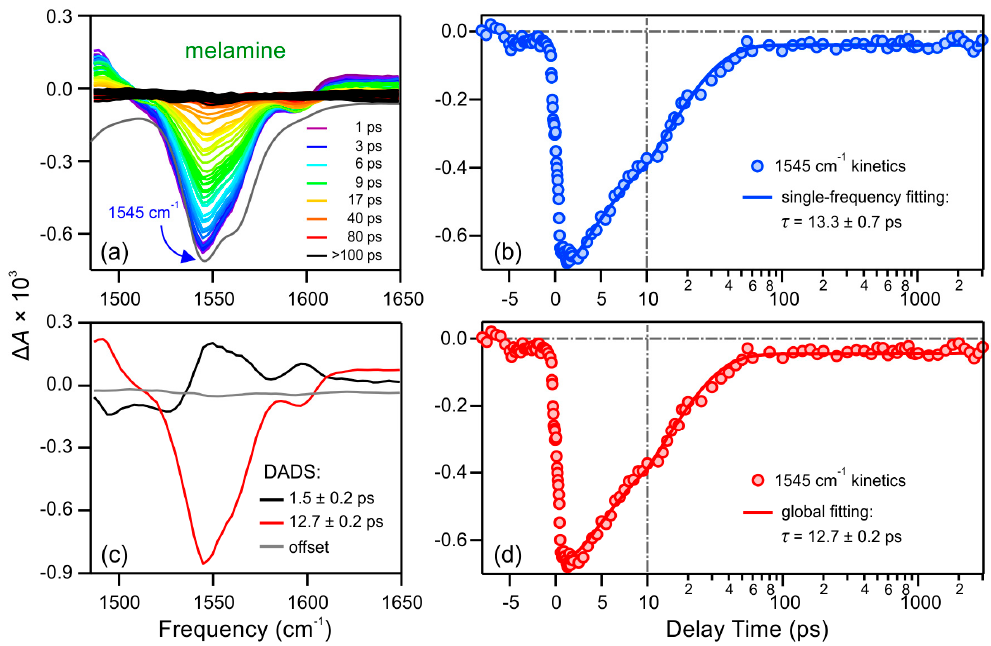
Figure 3. ( a ) TRIR spectra of melamine in neutral D 2 O solution recorded from 1 ps ( purple ) to 3 ns ( black ) after 240 nm excitation. The inverted FTIR spectrum ( gray ) is shown for comparison. The blue curved arrow points to the frequency of the kinetic trace presented in panel ( b ); ( b ) Bleach recovery kinetic trace at 1545 cm − 1 . The blue points are experimental data. The solid blue line is the best-fit curve A 1 e − t / τ 1 + A 2 e − t / τ 2 + A 3 ; ( c ) Decay-associated difference spectra (DADS) obtained from global fitting; ( d ) Bleach recovery kinetics trace at 1545 cm − 1 overlaid with the best-fit curve obtained from global fitting. The vertical dash-dotted lines mark the linear-logarithmic break in the time axis. The time constants obtained from single-frequency and global fits are indicated together with 2 σ uncertainties.